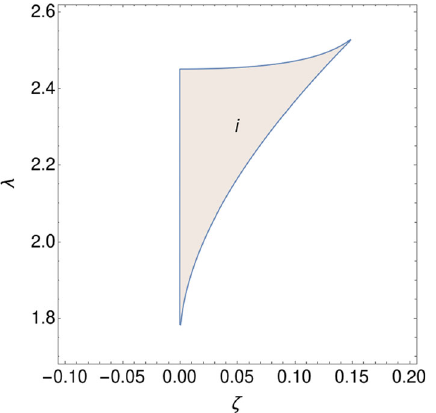
Fig. 4 Region of existence of solution H + when α = β ≡ ζ . It con- tains saddle points